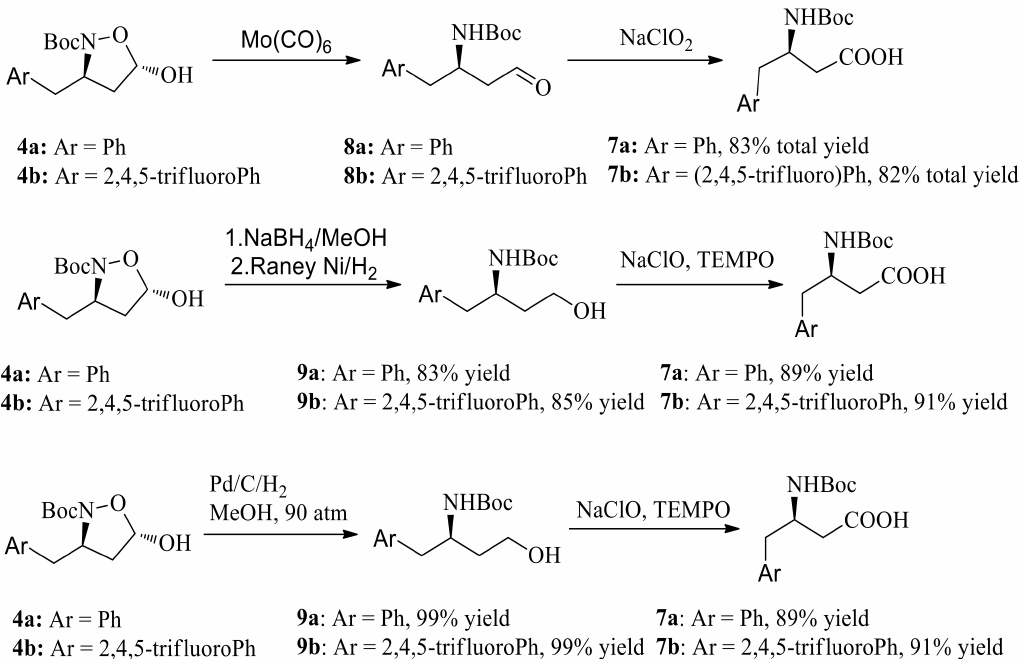
Scheme 5. Reductive cleavage of N-O bond/oxidation